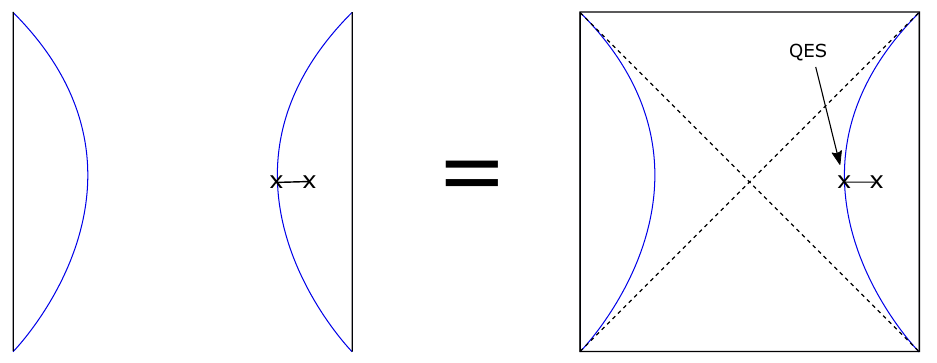
Figure 4 . The QES is given as the degenerate surface which sits right on the cutoff